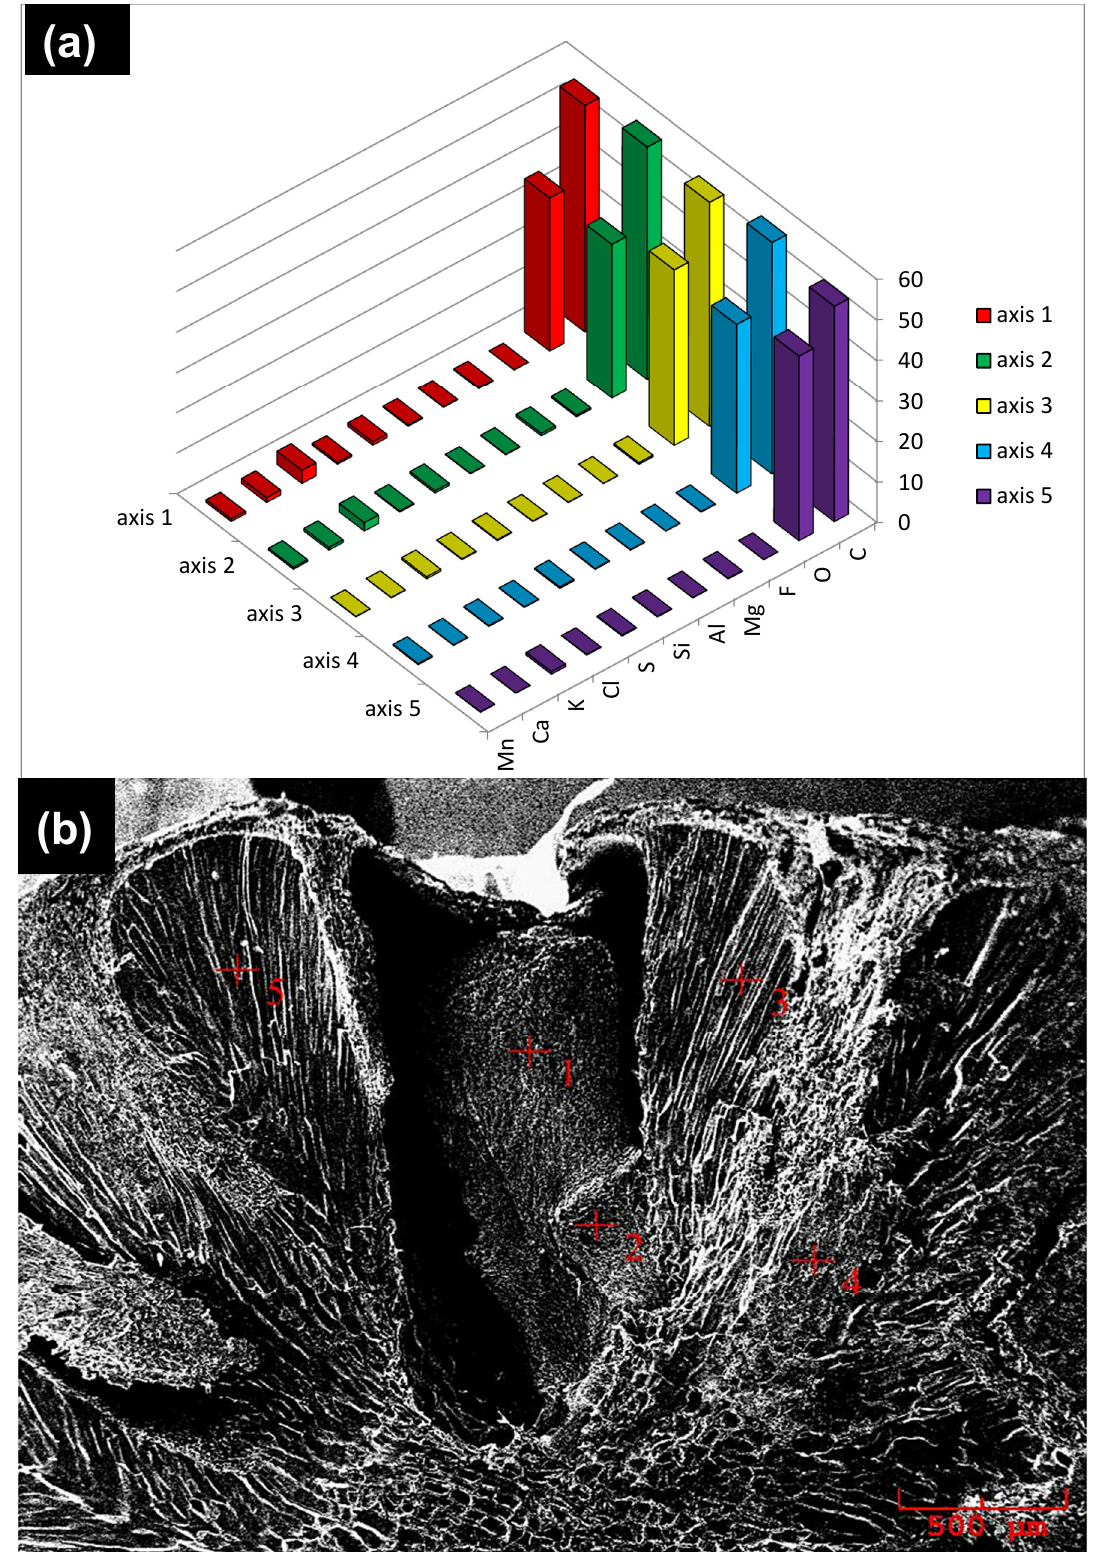
Figure 3. The Acaizeiro, Amazonian palm can occur in both mainland and varzea soils. EDS of mainland açaí palm seeds ( a ) and SEM of mainland açaí palm seeds ( b ).